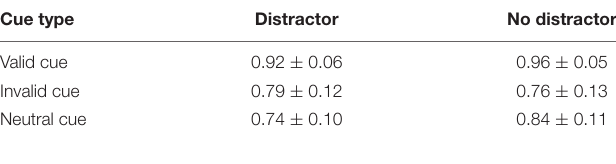
TABLE 1 | Mean accuracy and standard deviation in each task condition.